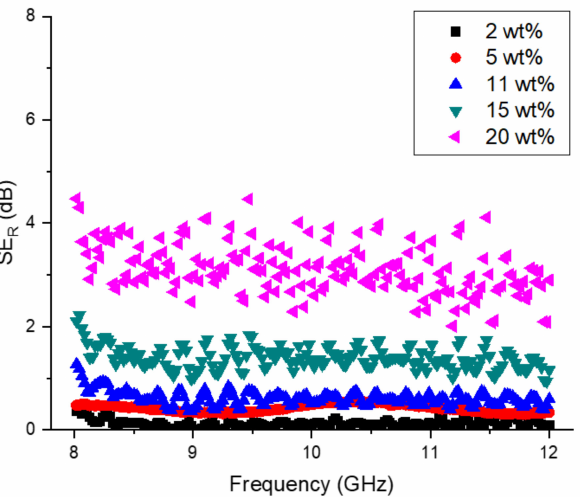
Figure 5. Shielding efficiency due to the reflection of CH/Na/CuSe polymer matrix with 2 wt% to 20 wt% of CuSe filler.